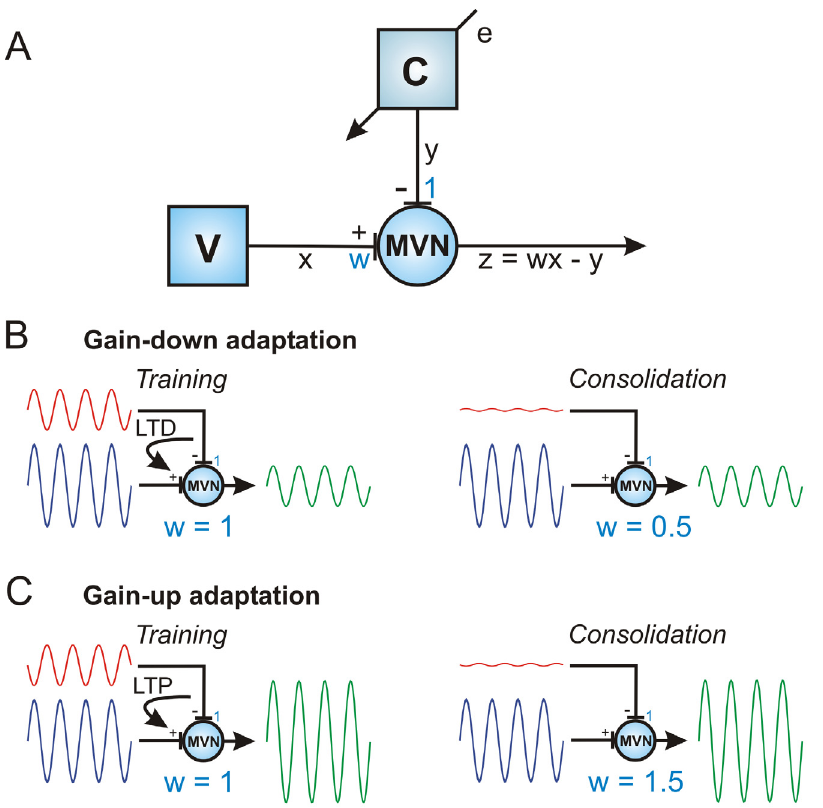
Figure 1. Correlational learning rule for regulation of vestibular synapse strength by cerebellar inhibition: transfer of VOR gain from cerebellar cortex to brainstem. A: Schematic diagram of vestibular and cerebellar inputs to MVN neuron. The input x t ð Þ from the vestibular periphery (V) arrives at an excitatory synapse with weight w . The input y t ð Þ from the cerebellum (C) arrives at an inhibitory synapse with nominal weight 1. The MVN output is treated as the linear combination z t ð Þ ~ wx t ð Þ { y t ð Þ of these two inputs. The input e t ð Þ to the cerebellum denotes the retinal-slip training signal assumed to mediate learning in cerebellar cortex. B: Illustration of situation for gain down learning. The brainstem gain w is too high so that the vestibular input on its own would produce an over-large vestibulo-ocular response. During training the cerebellum has learnt to produce an inhibitory input modulated in phase with the vestibular input, leading to cancellation which produces a 50% gain decrease (since z ~ wx { y and y ~ 0 : 5 x , a weight w ~ 1 requires z ~ 0 : 5 x ). The same result could be produced without the need for cerebellar input if the vestibular afferent synaptic strength (represented by the weight w ) was reduced during consolidation to half its value (since w ~ 0 : 5 requires z ~ 0 ). Hence in- phase (positively correlated) inputs to the MVN should drive a long-term depression (LTD) at vestibular afferent synapses during consolidation. C: Illustration of situation for gain up learning. In this case the out-of-phase cerebellar and vestibular afferent inputs to the MVN neurons should drive a long-term potentiation (LTP) of the vestibular afferent synapses during